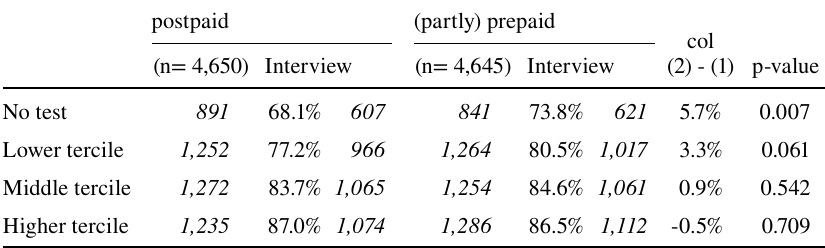
Wave 6 Response Rates by Reading Proficiency (N= 9,295)